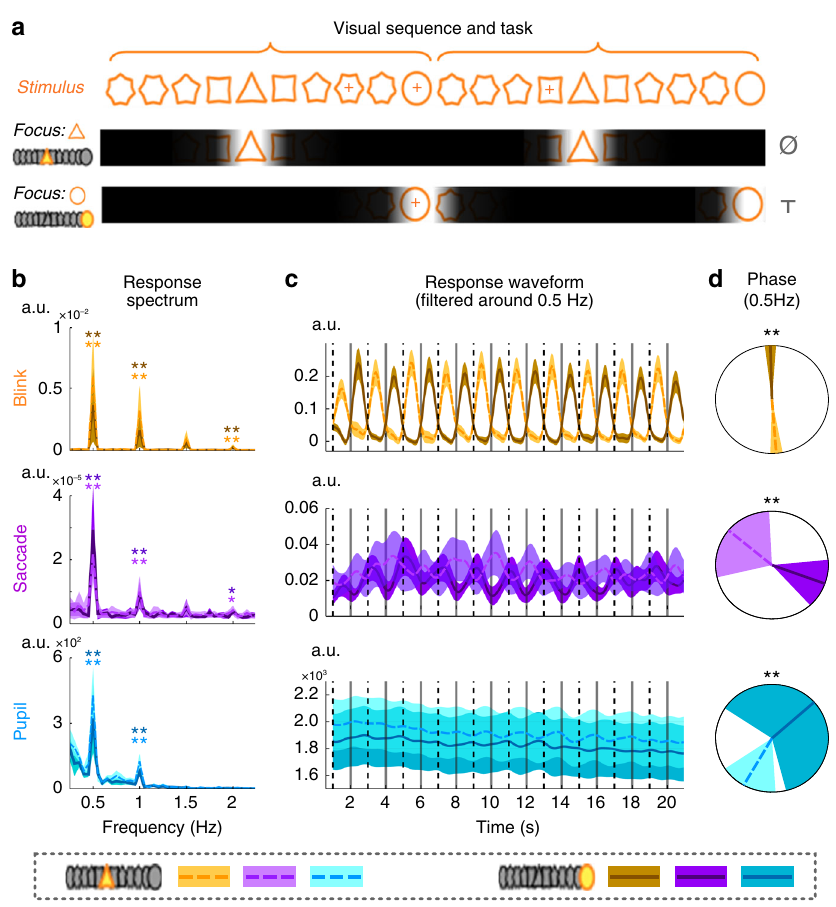
Fig. 6 Ocular activity tracks structures in a visual sequence and its phase is modulated by temporal attention. a Stimulus and task. The stimulus is a sequence of shapes that repeats every 2 s. The task is to attend to the 5th shape in each 2-s period, i.e., a triangle, in one condition and to attend to the 10th shape, i.e., a circle, in the other condition. Unattended visual shapes are shaded in the illustration. The listeners detect whether a cross appears at the center of the attended shape. In the illustration, T means that a target appears while Ø means that no target appears. The shapes are described in details in Supplementary Fig. 3. b Response spectrum, in which response peaks at 0.5 Hz are observed (see Supplementary Table 6 for the P -value, mean, and SEM), corresponding to neural tracking of the 2-s period in the visual sequence. In all panels, dashed lines and lighter color indicate conditions attending to the 5th shape while solid lines and darker color indicate conditions attending to the 10th shape. The onset of the 5th shape is marked by a dashed vertical line while the 10th shape is marked by a solid line. In panels b and c , shaded area is 1 SEM across participants ( N = 16) on each side. c Response waveform fi ltered around 0.5 Hz, which is strongly modulated by attention. The shaded area covers 1 SEM across participants on each side. d The response phase extracted by the Fourier analysis. The shaded area covers the 95% con fi dence interval of the mean phase. * P < 0.05; ** P < to temporal attention or high-level sequential structures, however, could be highly complex and need to be characterized by future current study extends these previous studies by showing that the brain imaging studies. For example, previous work has shown phase of low-frequency neural activity tracks attended syllables in that the cerebellum controls the timing of blinks during eyelid a sentence and by showing ocular synchronization to the atten- tional focus. Why is oculomotor activity synchronized to temporal atten- tion? It is known that parts of the attention network 42,55 , including the frontal eye fi elds (FEF) and posterior parietal cortex (PPC), are also involved in controlling eye movements and eye blinks 36,37 . Furthermore, the timing circuits in the brain also overlap with the motor system and includes, e.g., the supple- mentary motor cortex, parietal cortex, cerebellum, and basal ganglia 3 . It has also been hypothesized that sensory and motor systems are both entrained to the attended stimulus rhythm 29 , and synchronized activity in distributed cortical networks pro- vides a potential mechanism to coordinate distributive neural processing 56 . In sum, attentional control, interval timing, and motor control all involve distributed networks in the frontal/ parietal lobes and sub-cortical nuclei, which potentially enables the interactions between temporal attention and ocular activity. The speci fi c neural networks involved in ocular synchronization either an auditory or visual task 40,60,61 . Similarly, the current